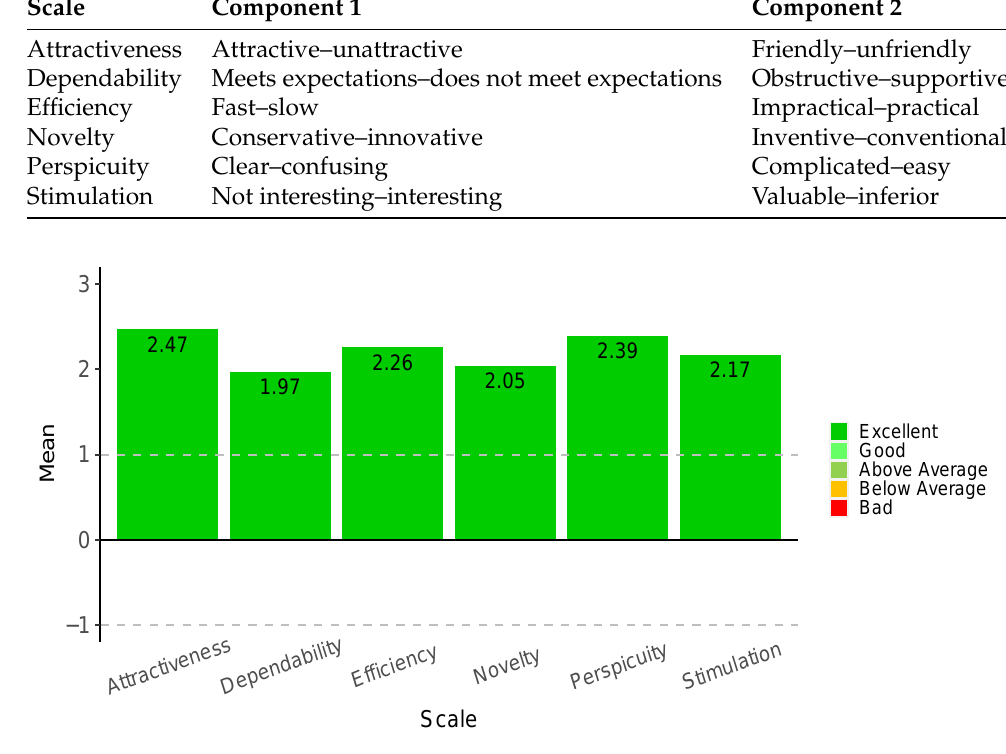
Figure 12. Results of the app evaluation using the UEQ